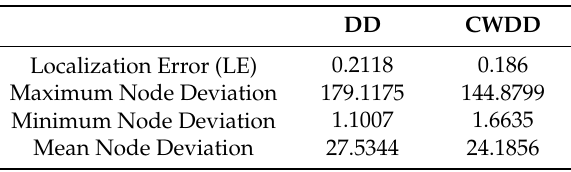
Table 2. Comparison: DD vs.